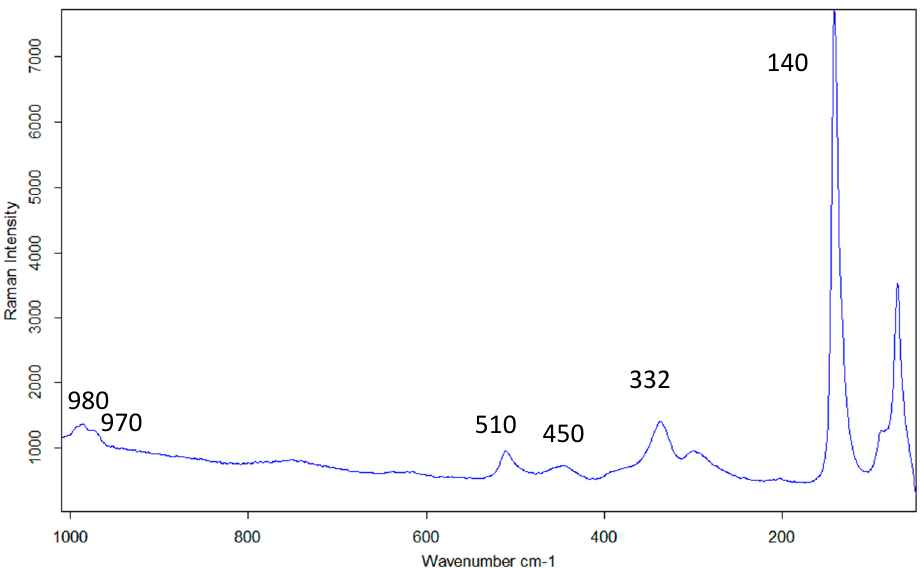
Figure 17. Raman spectrum acquired on lead–tin–antimonate crystals (DMS_11 green/yellow sample from the Great Mosque of Damascus, Syria—unpublished data [24,25]), with bands at 140, 332, 450, and 510 cm − 1 consistent with lead antimonate doped with tin [57]. Note the additional bands at 970–980 cm − 1 , ascribable to noselite [32].